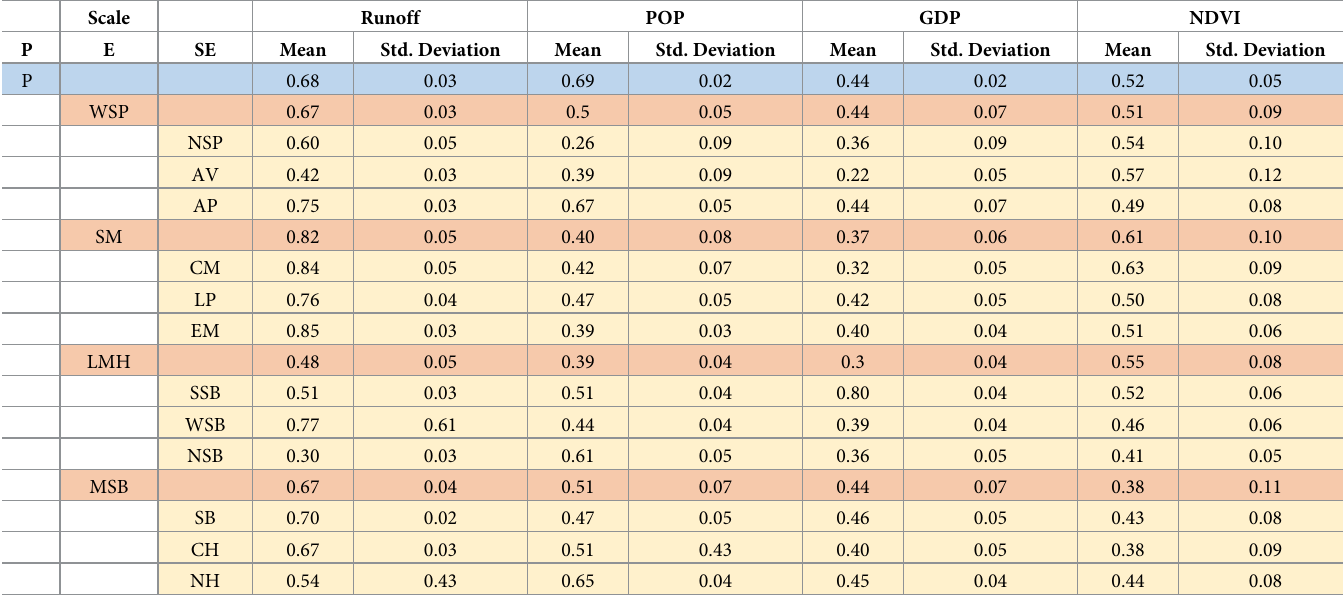
Table 3. Statistical summary of the local regression coefficients of water yield at the provincial (P) scale, ecoregion (E) scale, and subecoregion (SE) scale (p < 0.05). Scale Runoff POP GDP NDVI P E SE Mean Std. Deviation Mean Std. Deviation Std. Deviation Std.